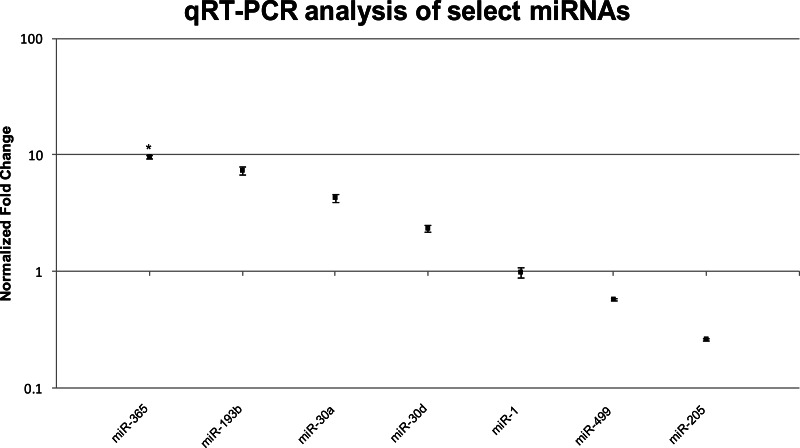
TaqMan® qRT-PCR analysis of seven miRNAs in EO and muscle of S. macrurus.Plots illustrating fold-change differences between EO and muscle in S. macrurus (n = 3). Data are shown as fold-changes ± standard error, graphed on a logarithmic scale with values >1 indicating increased expression in EO relative to muscle and values <1 indicating decreased expression in EO relative to muscle. Data points marked with asterisks are significantly differentially expressed between EO and muscle (adjusted p-value < 0.05).